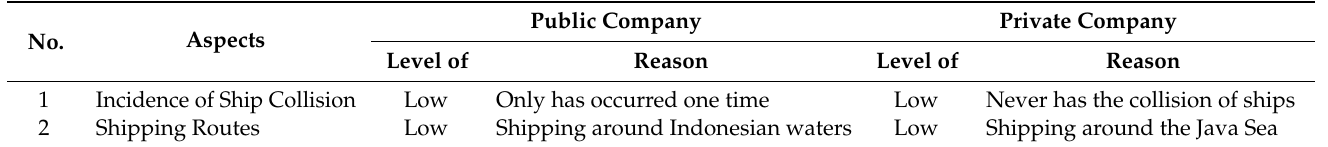
Table 3. Magnitude of risk assessment in the public